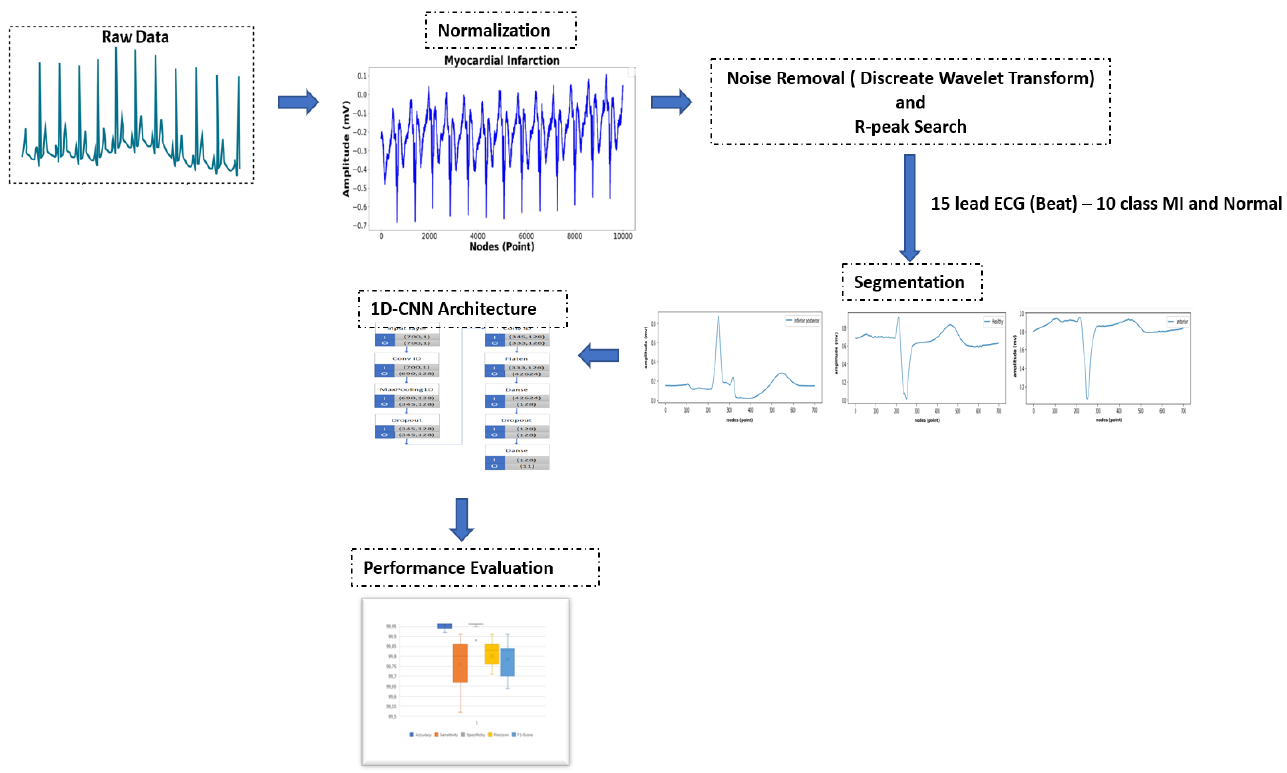
Figure 1. The proposed research methodology.